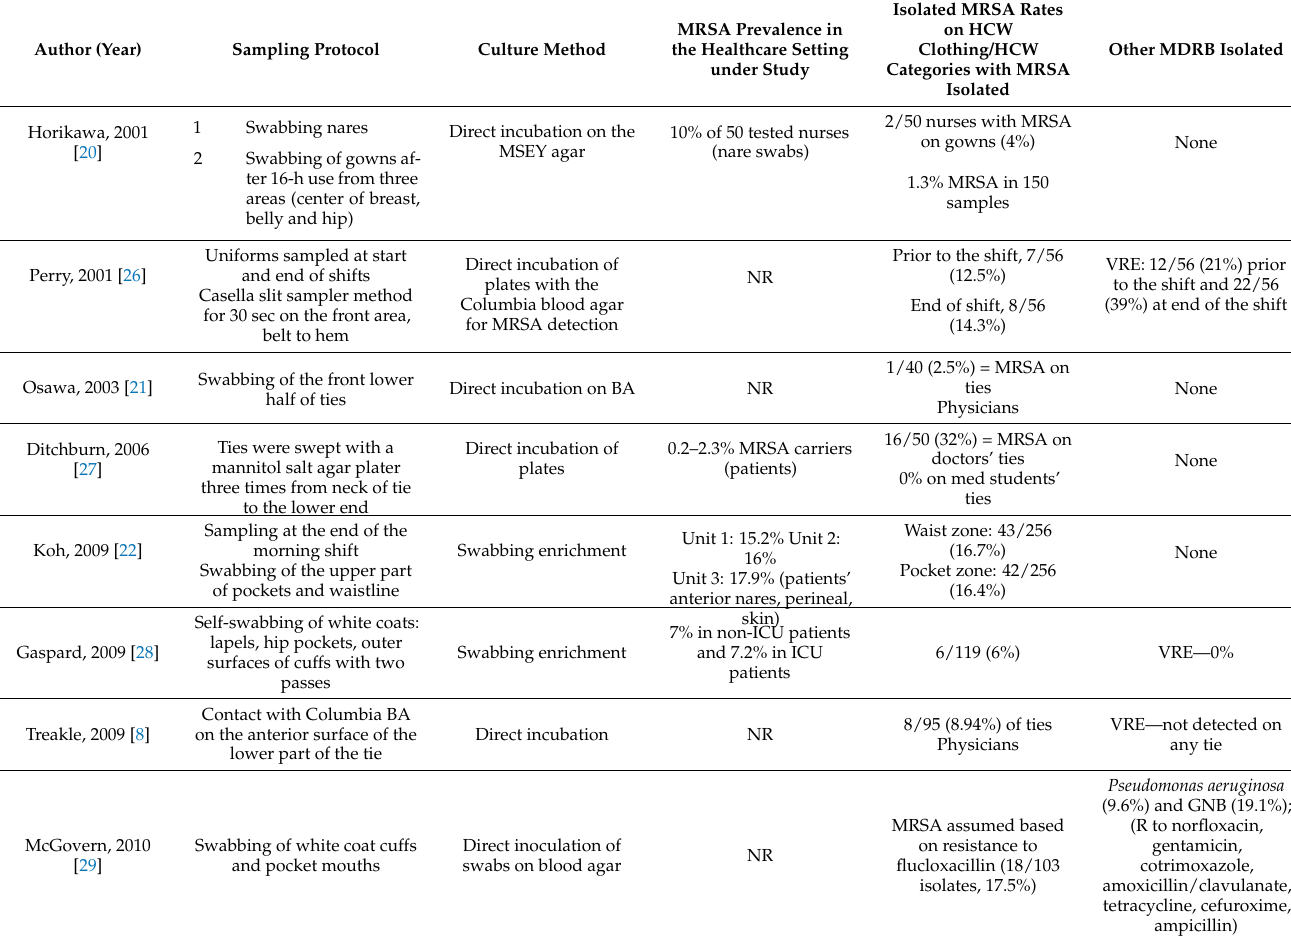
Table 2. Sampling protocols, culture methods and MRSA isolation rates in the included